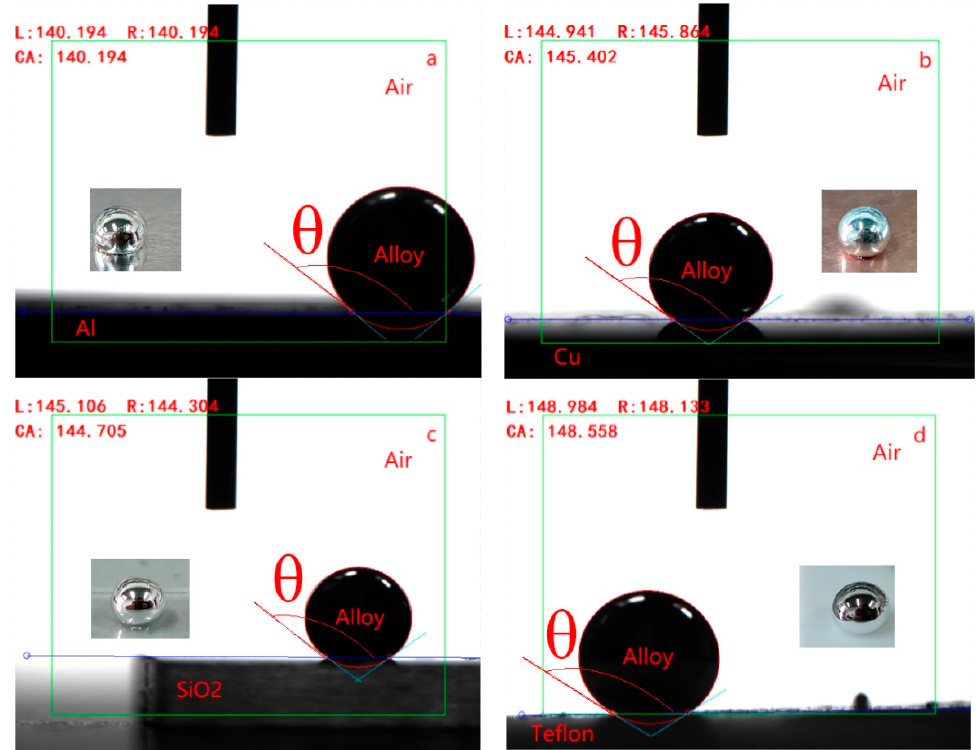
Figure 6. Contact angle between Ga 80 In 10 Sn 10 and ( a ) Al substrate, ( b ) Cu substrate, ( c ) SiO 2 substrate, ( d ) Teflon substrate (20 ◦ C). Table 3. Contact angles of different gallium-based alloys on different plates at 20 ◦ C.